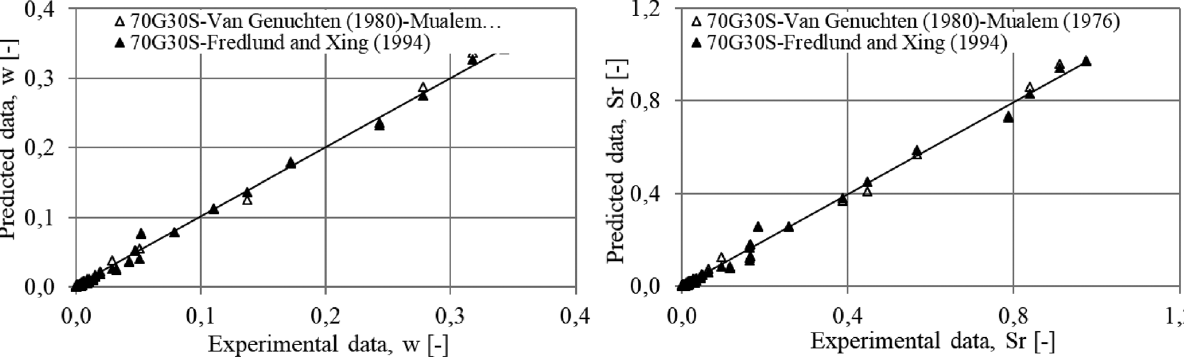
Figure 11: Veri fi cation of experimental with predicted data of SWCC: ( left ) gravimetric water content ( w ) results and ( right ) degree of saturation ( Sr ) results for 70G30S soil.